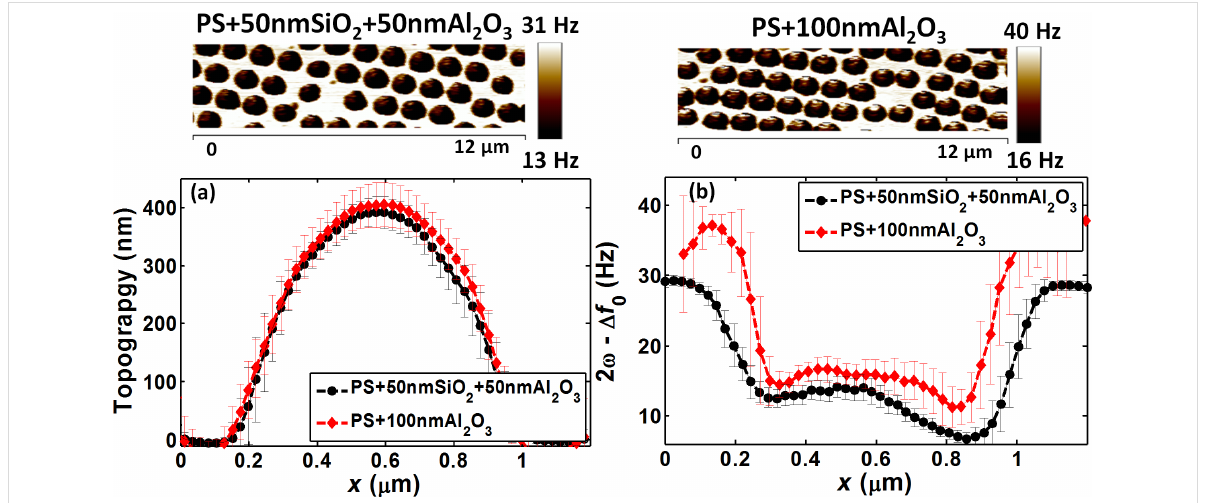
Figure 10: Approach 3 - Step C (PS + 50 nm SiO 2 + 50 nm Al 2 O 3 and PS + 100 nm Al 2 O 3 samples). a) Average topography profiles, b) average EFM signal profiles (lower panel) and the corresponding EFM images (upper panels).